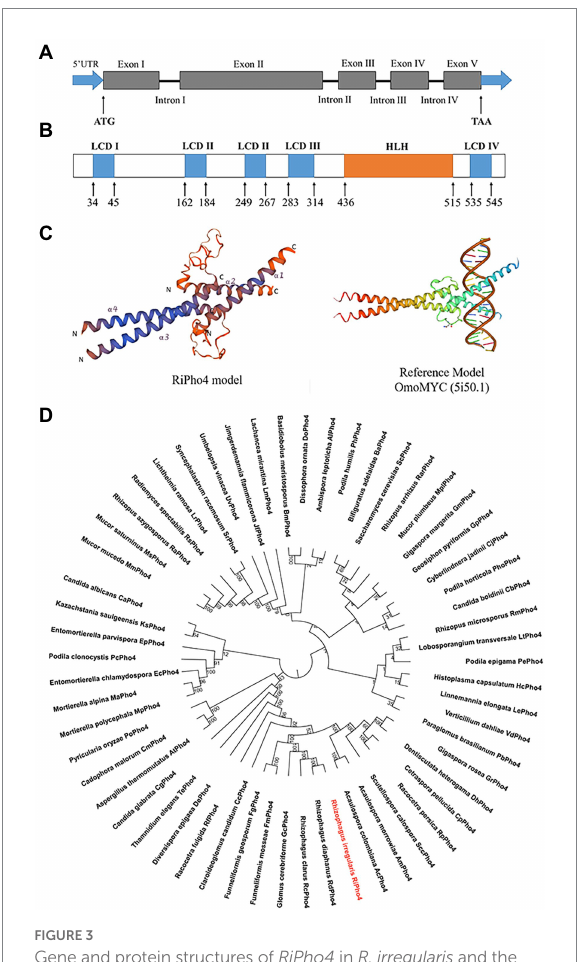
FIGURE 3 Gene and protein structures of RiPho4 in R. irregularis and the evolutionary relationships with Pho4 proteins in various fungi species. (A) The RiPho4 gene contains five exons and four introns, corresponding to gene ID 36869193. The untranslated regions (UTRs) are shown in the figure, ATG and TAA represent the translation start site and translation termination site, respectively. (B) Inferred protein domain of RiPho4. RiPho4 protein contains 570 amino acids and consists of one HLH domain and four low complex domains (LCDs) (http://smart. embl.de/). (C) Predicted three-dimensional structure of RiPho4 model by SWISS-MODEL. It was predicted that the 3D structure of RiPho4 is similar to that of OmoMYC (5i50.1), a protein encoded by MYC dominant-negative allele in Mus musculus (Jung et al., 2017). (D) The unrooted phylogenetic tree was constructed with the neighbor-joining method, based on multiple sequence alignments of RiPho4 (red color) and other Pho4 proteins from different fungi species using MEGA v7.0 software. Bootstrap tests were performed using 1,000 replicates. The accession numbers of all Pho4 proteins are provided in the Supplementary Table